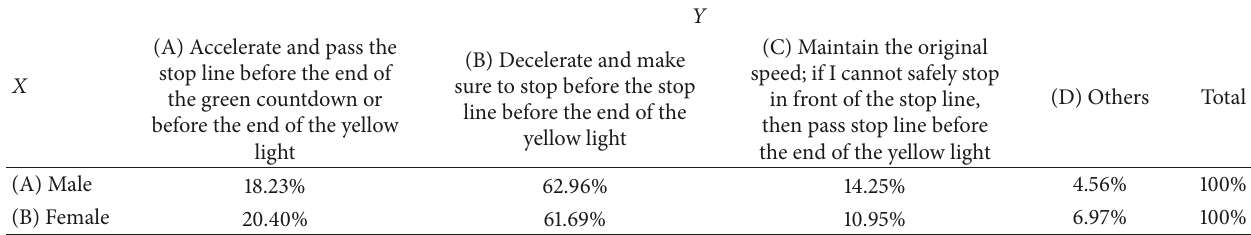
Table 13: Cross-analysis between gender and behaviors before the end of the green